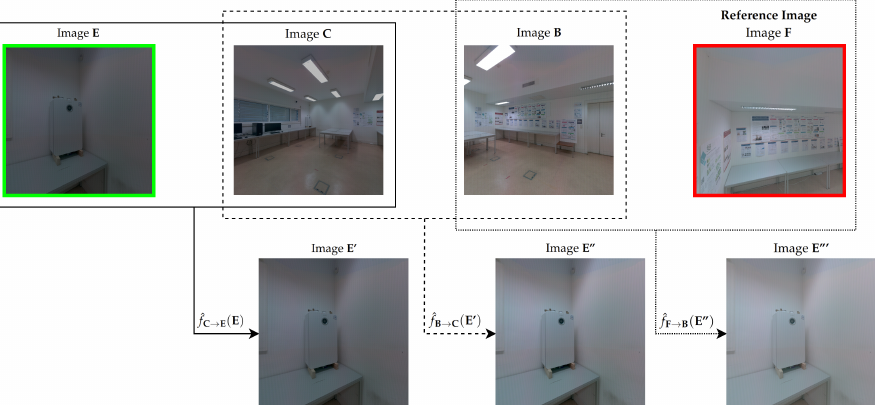
Figure 8. Example of the sequential pairwise color correction for a color correction path from a target image (in green) to a reference image (in red). On the first row are the four images that compose the color-correction path. On the second row are the color-corrected images, after each step of the sequential pairwise color correction. Each box (solid, dashed and dotted) represents a step of the sequential pairwise color correction, showing the CMF used and its input image. To explain our point, we drastically changed the brightness of the images on purpose, because some changes in the color of the images along the steps of the color correction procedure are not always easy to